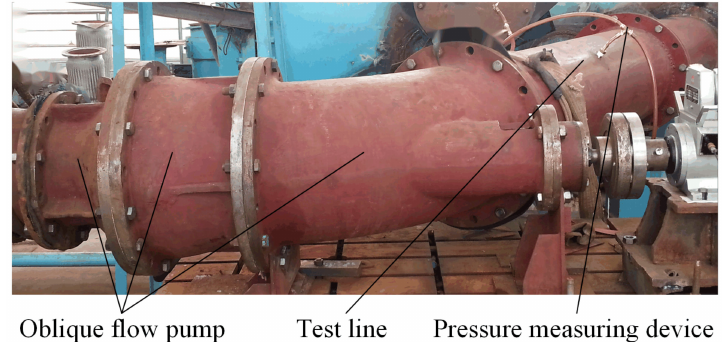
Figure 4. Test device